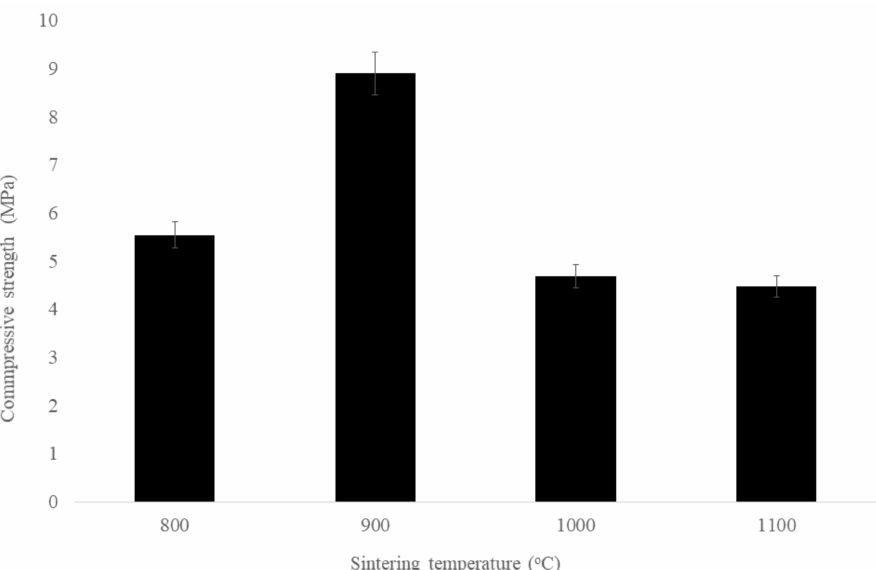
Figure 2. Effect of sintering temperature on the compressive strength of sintered kaolin- GGBS